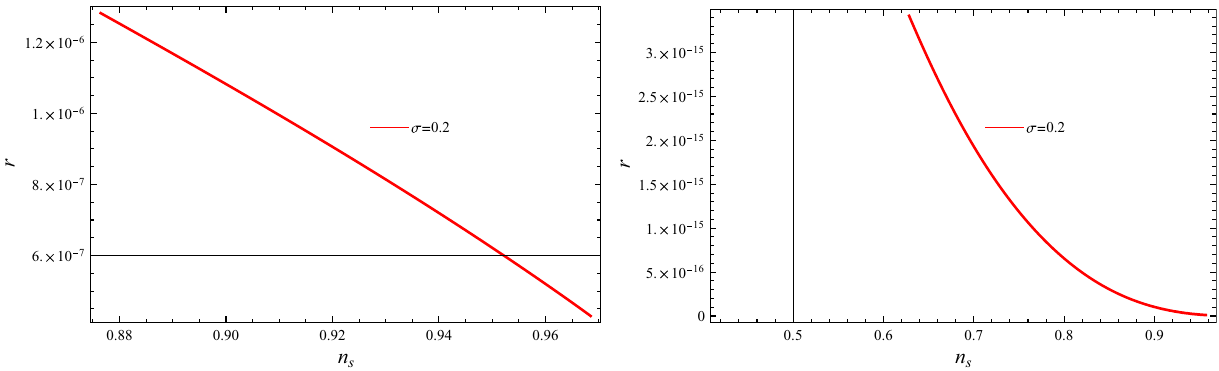
Fig. 1 Plot of r versus n s for GCG model in weak (left panel) and strong (right panel) dissipative regimes for positive potential with n = 1